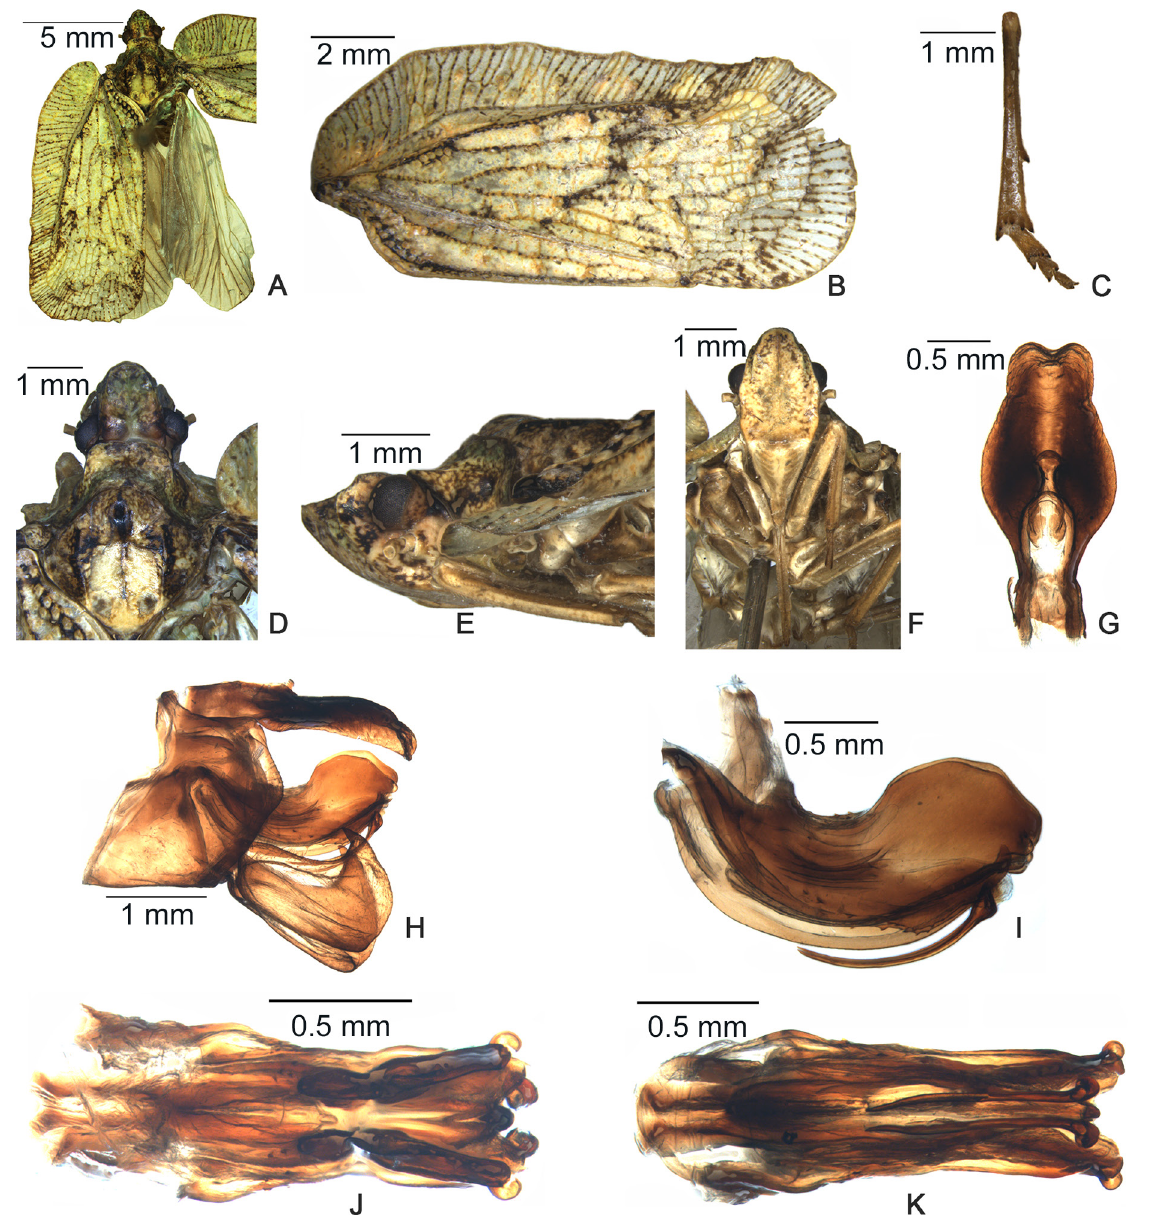
Fig. 6. Atracis punctulata sp. nov., holotype, ♂ (NWAFU). A . Habitus, dorsal view. B . Tegmen. C . Hind leg apex. D . Head and thorax, dorsal view. E . Head and thorax, left lateral view. F . Face. G . Male anal tube, dorsal view. H . Male genitalia, right lateral view. I . Phallic complex, right lateral view. J . Phallic complex, dorsal view. K . Phallic complex, ventral